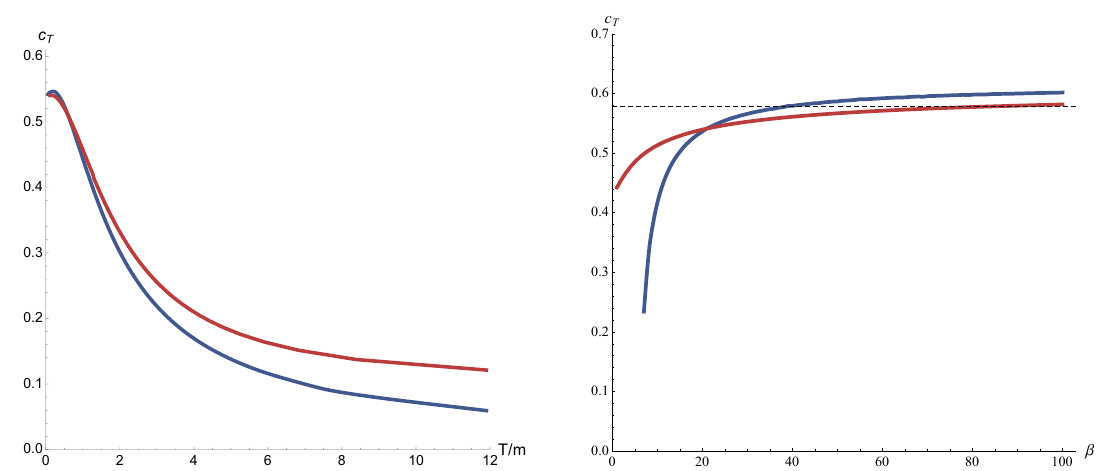
Figure 6 . Comparison between the velocity obtained from the QNMs (red line) to the velocity given in eq. (4.1) (blue line). Left: the velocity as a function of temperature for (cid:12) = 20. Right: the velocity as a function of (cid:12) for T=m = 0 : 05. (As a cross-check let us mention that the velocities evaluated at T=m = 0 : 001 coincide with the results shown